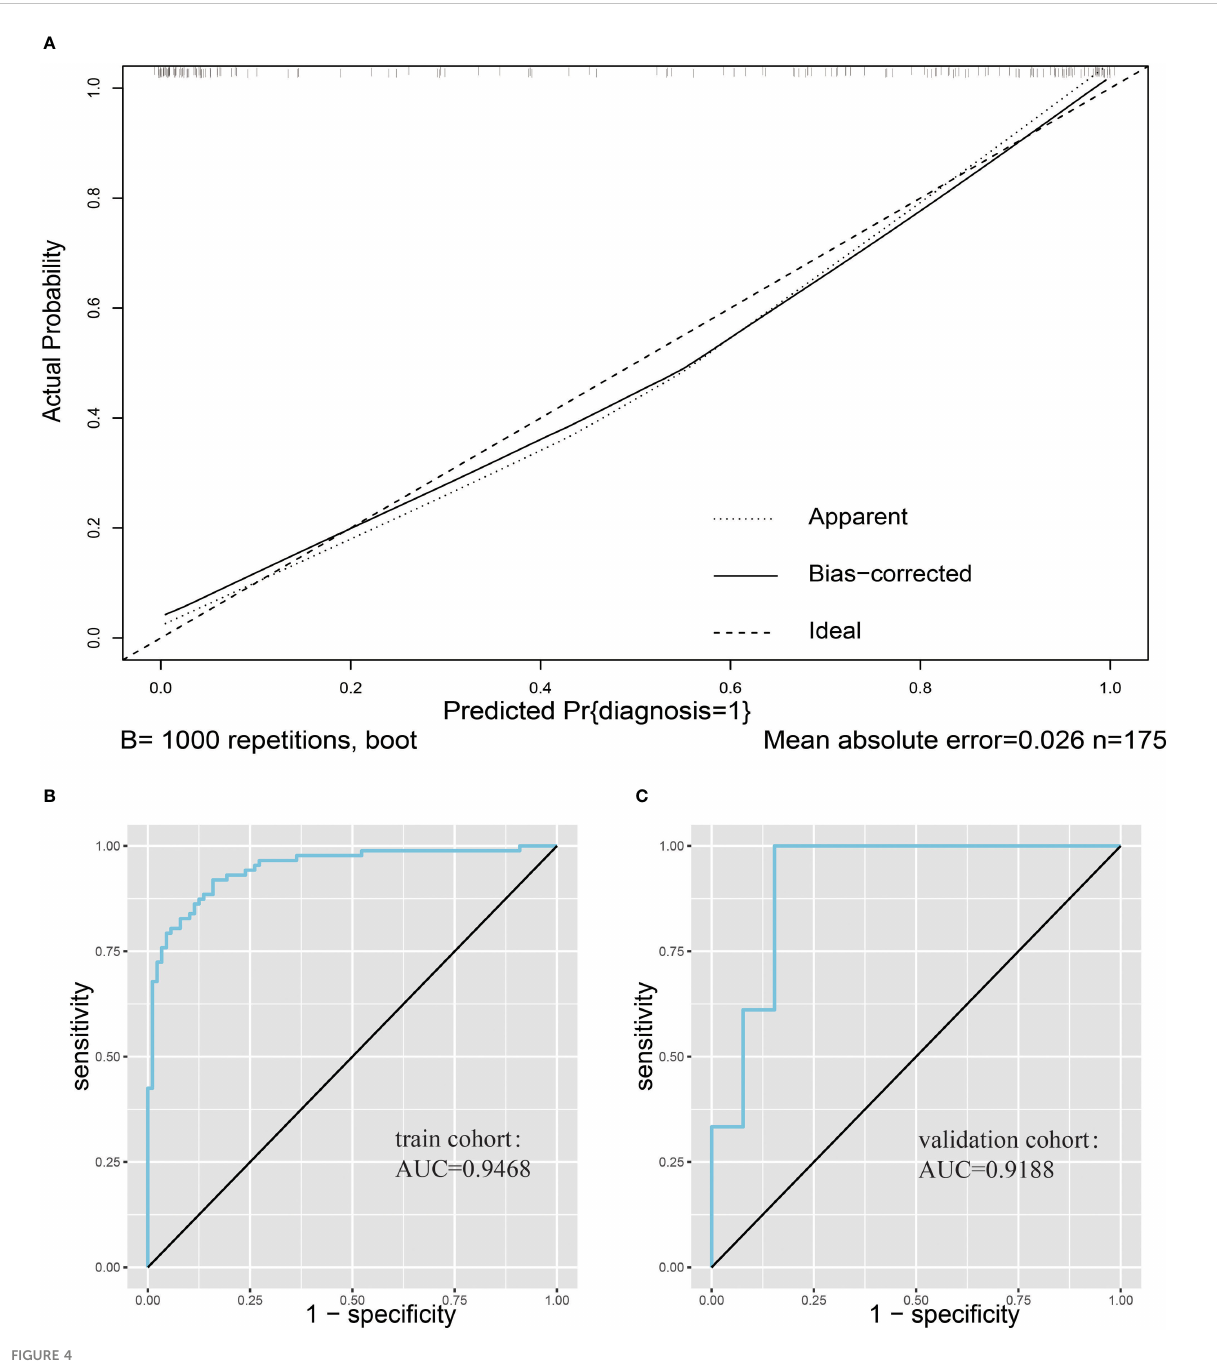
FIGURE 4 Evaluation of nomogram clinical prediction models. (A) , Calibration curve of the model. (B) , ROC curve of the model for the training cohort, and its AUC was 0.9468. (C) , ROC curve of the model for the validation cohort, and its AUC was